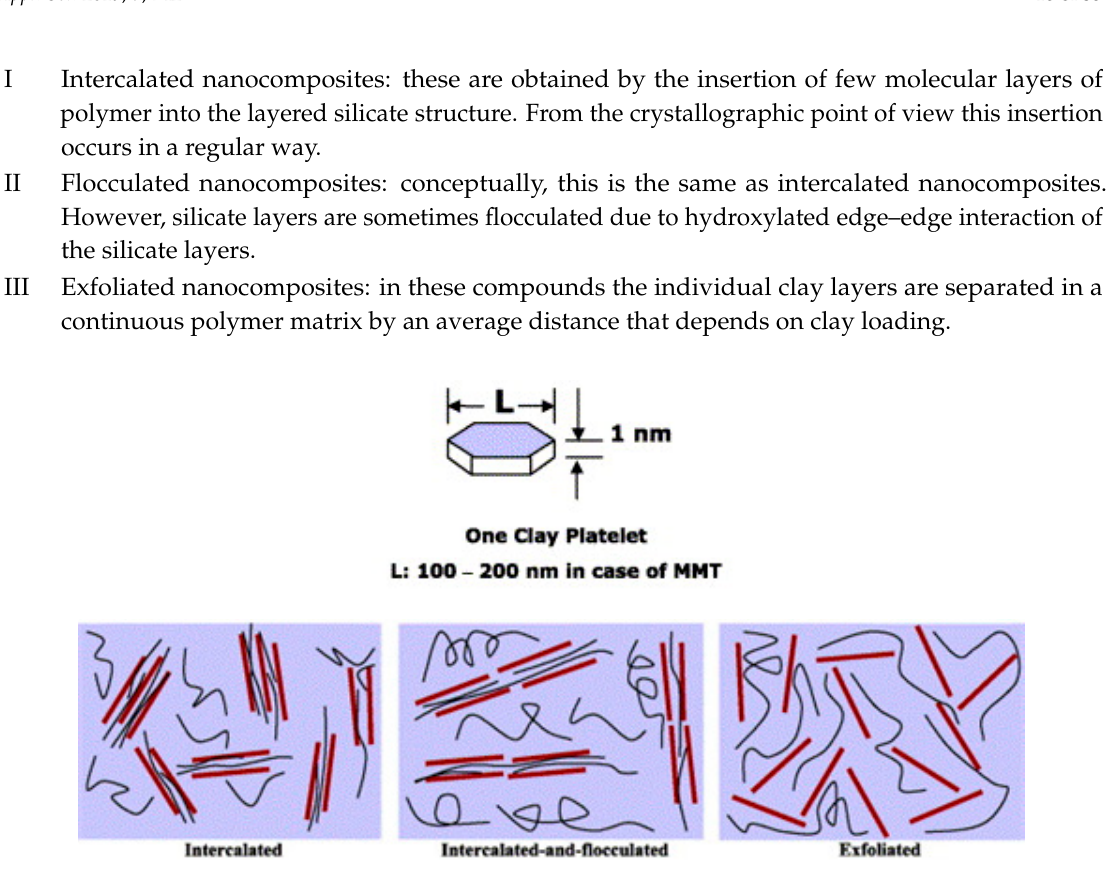
Figure 10. Illustration of three different types of polymer/layered silicate nanocomposites (reprinted from [199] with the permission of Elsevier).